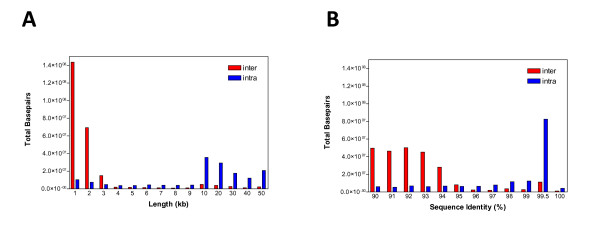
The distribution of length and percent identity for high-confidence segmental duplication detected by WGAC and WSSD. Panel A shows the length distributions while panel B shows the pairwise sequence identity distribution for the segmental duplications. Red, interchromosomal segmental duplications; blue, intrachromosomal segmental duplications.